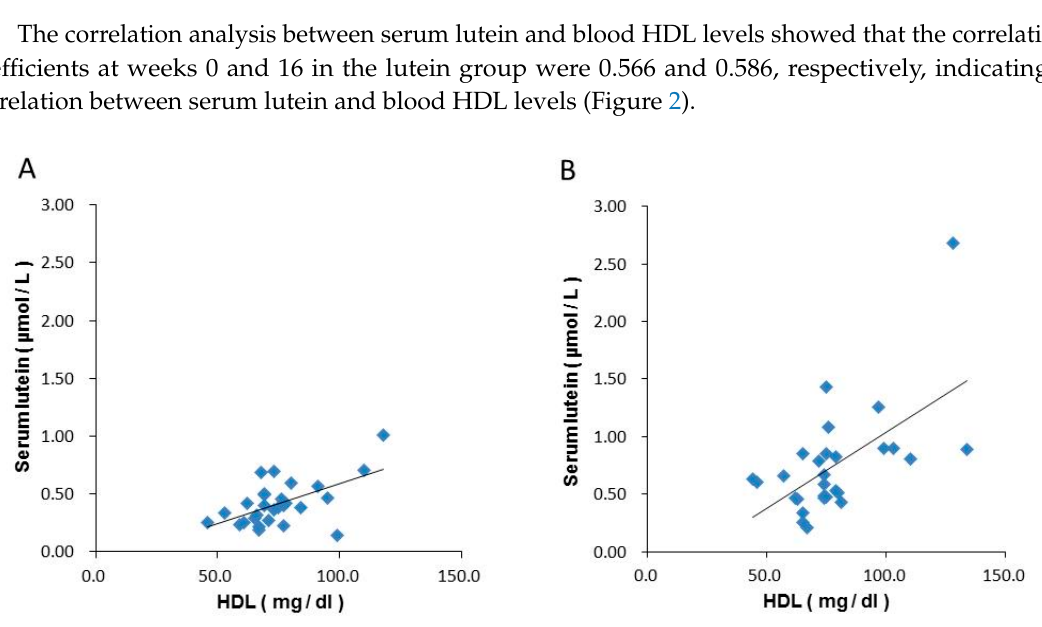
Table 5. Changes in contrast and glare sensitivities during supplementation.